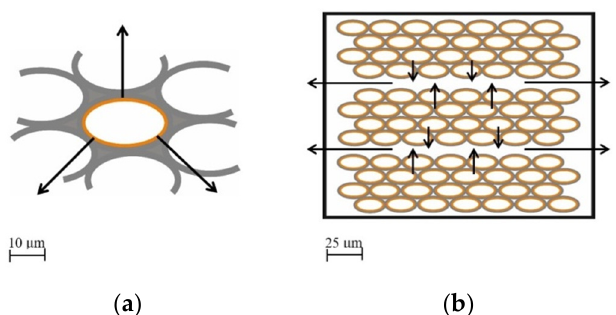
Figure 5. Scheme of the main diffusion fluxes of resveratrol in water extraction (indicated by arrows) for a particle of 32 μ m ( a ) and 350 μ m ( b ).